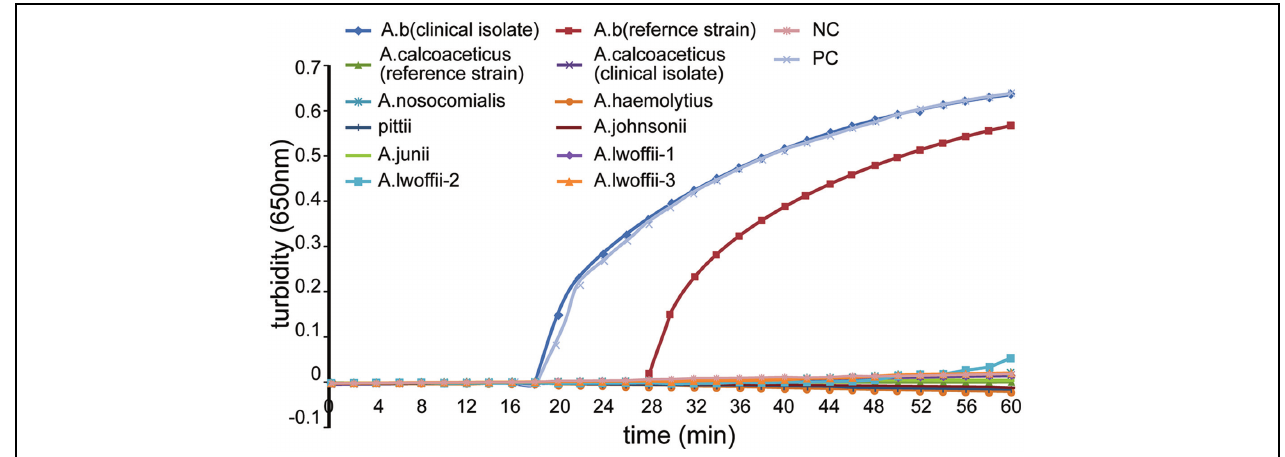
FIGURE 3 | Specificity of the LAMP reactions in detecting the bla OXA − 51 − like gene. Turbidity was monitored using a Loopamp real-time turbidimeter by measuring the absorbance at 650 nm every 6 s. Amplification was performed at 65 ◦ C for 60 min.